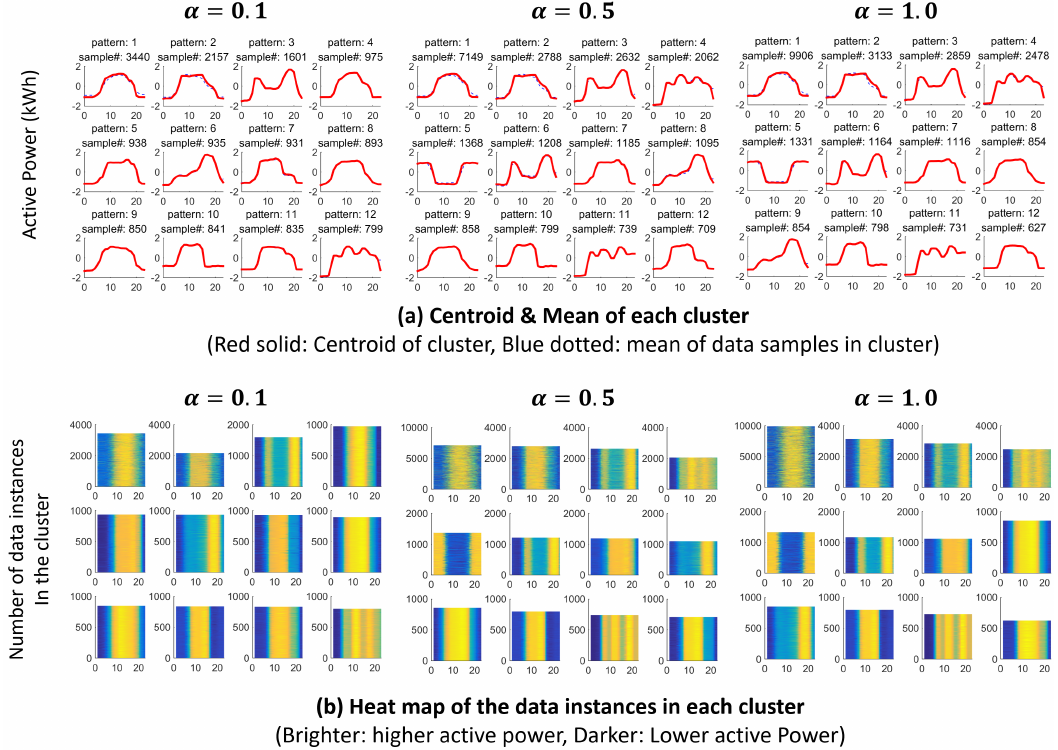
Figure 6. Clustering results of DOE data set with Euclidean distance.